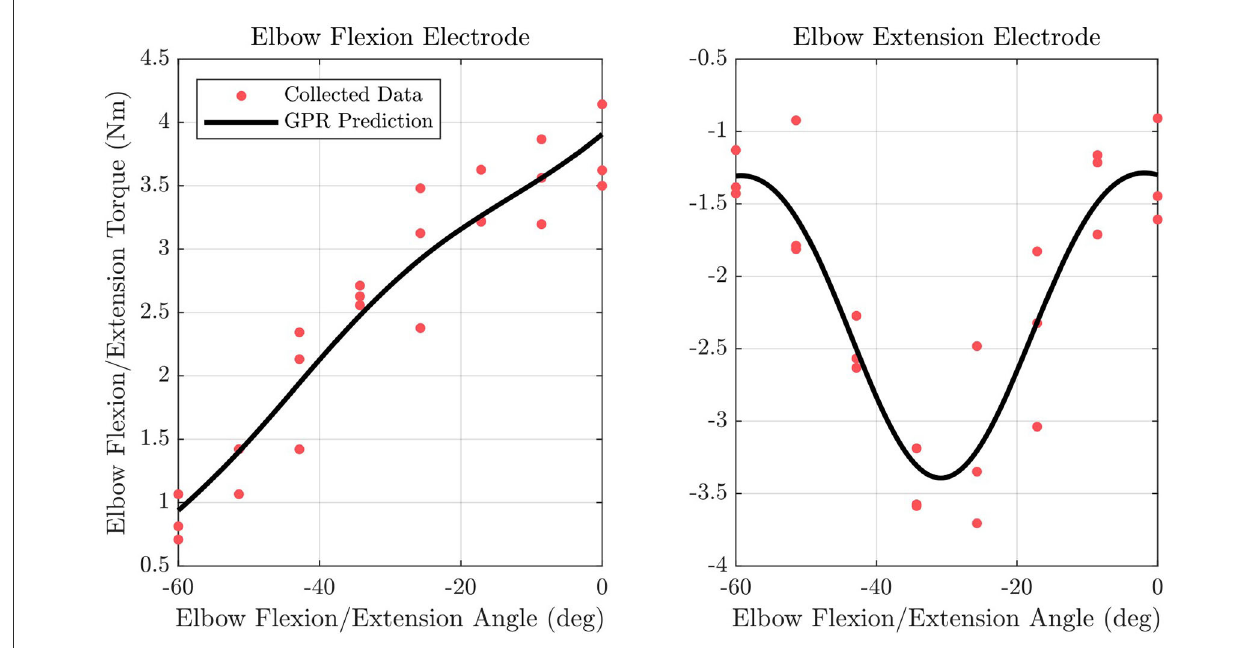
FIGURE4 Fitted GPR models are shown along with data points used to fit the model for the elbow flexion/extension joint for the elbow flexion and elbow extension